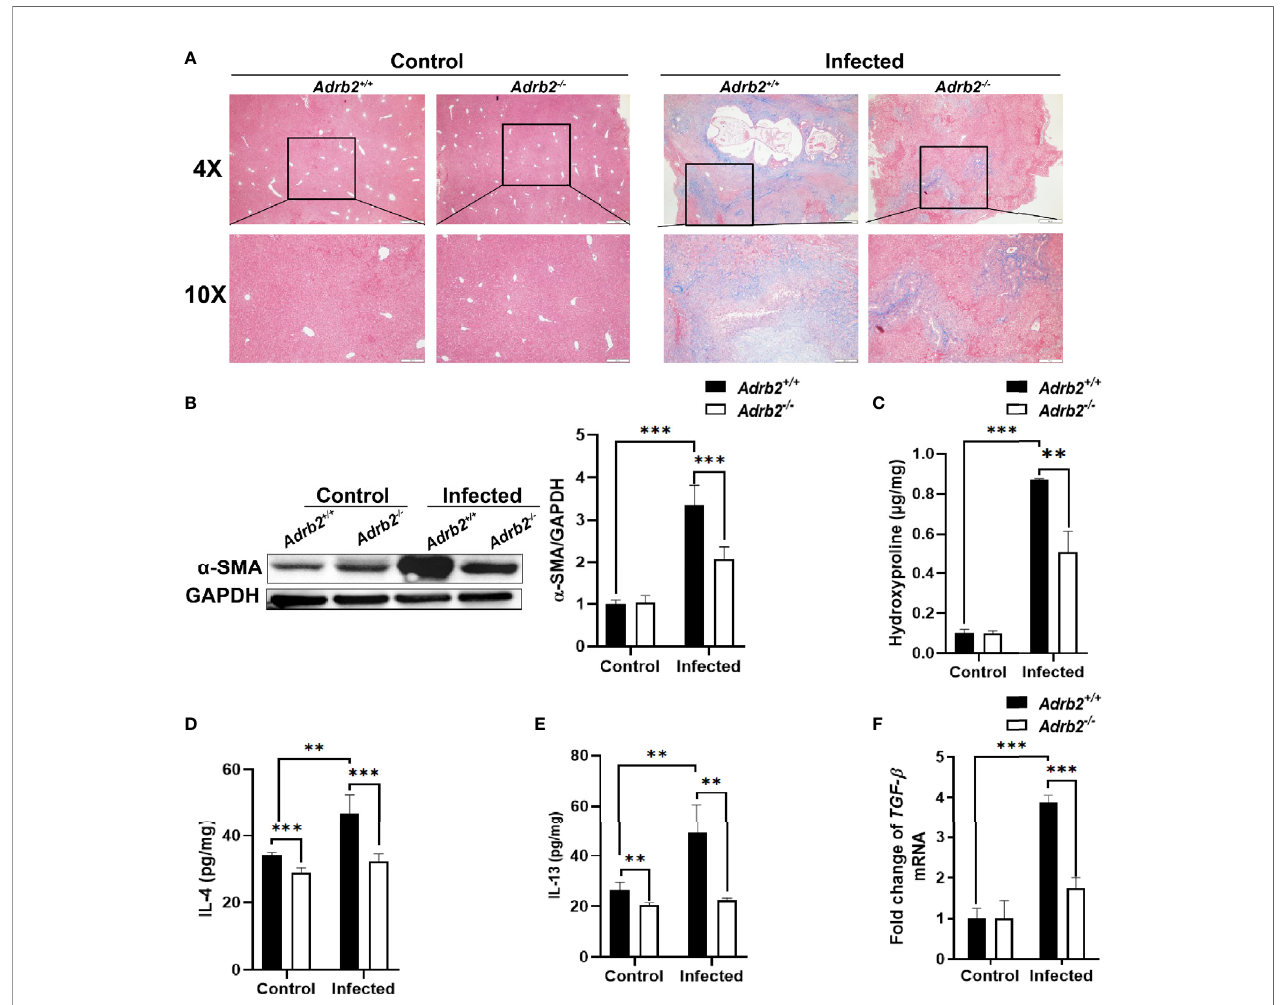
FIGURE 3 | The knocking out of b 2-AR prevents the increase in type 2 cytokine after Clonorchis sinensis infection. The experimental setup of the in vivo model used n = 4 mice in the control group and n=6 mice in the infected group. The mice were divided into control Adrb2 +/ + , Adrb2 − / − and infected Adrb2 +/ + , Adrb2 − / − . (A) The Masson ’ s staining of the liver tissue was carried out in the control and infected group. The infected group showed a signi fi cant accumulation of collagen fi bers, as shown by the intense blue color; however, Adrb2 − / − signi fi cantly decreased collagen fi bers accumulation compared to Adrb2 +/ + . (B) The alpha SMA expression in the liver of control and infected mice. The liver expression of alpha SMA in the control group was signi fi cantly lower than that observed in the infected group ( P < 0.001 ). Also, the expression of alpha SMA in the infected group was signi fi cantly higher in infected Adrb2 +/ + than infected Adrb2 − / − ( P < 0.001 ). (C) The measurement of Hydroxyproline content showed an increase in the infected group than the control group, and the increase in the hydroxyproline content was higher in infected Adrb2 +/ + compared to infected Adrb2 − / − ( P < 0.01 ). (D – F) Measurement of the production of type 2 cytokines IL-4 and IL-13 and the relative mRNA expression of TGF-beta in liver tissue of control and infected mice. b 2-AR-de fi cient mice prevented the increase in the production of IL-4, IL-13, and tgf-beta after Clonorchis sinensis infection. The infected Adrb2 +/ + showed a signi fi cant increase in the production of IL-4 ( P < 0.001 ), and IL-13 ( P < 0.01 ), and the increase in the mRNA expression of tgf-beta ( P < 0.001 ), compared to the control group and infected Adrb2 − / − group. Compared with indicated groups, ** P < 0.01, *** P <